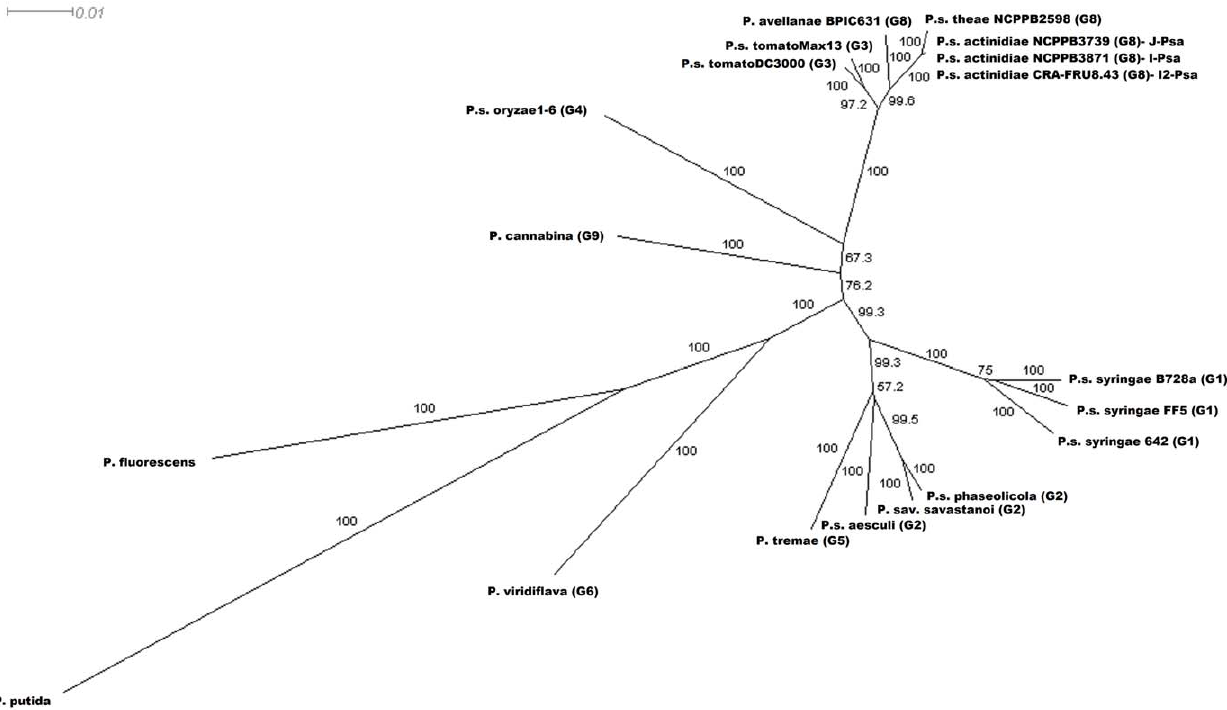
Figure 4. Evolutionary relationships of Psa strains to other phytopathogenic pseudomonads. Phylogenetic relationships were estimated from concatenated sequences from three housekeeping genes, gyrB , rpoB and rpoD (1,646 bp), using the neighbour-joining (NJ) algorithm. Bootstrap values are reported at each branching. Members of all nine genomospecies (Gardan et al., 1999), except genomospecies 7, are included into the analysis. The letter followed by the number reported in brackets indicates the genomospecies sensu Gardan et al. [7].